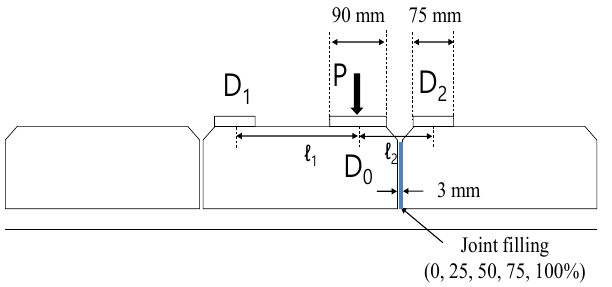
Figure 4. Method of measuring the LTE and concrete block rotation.